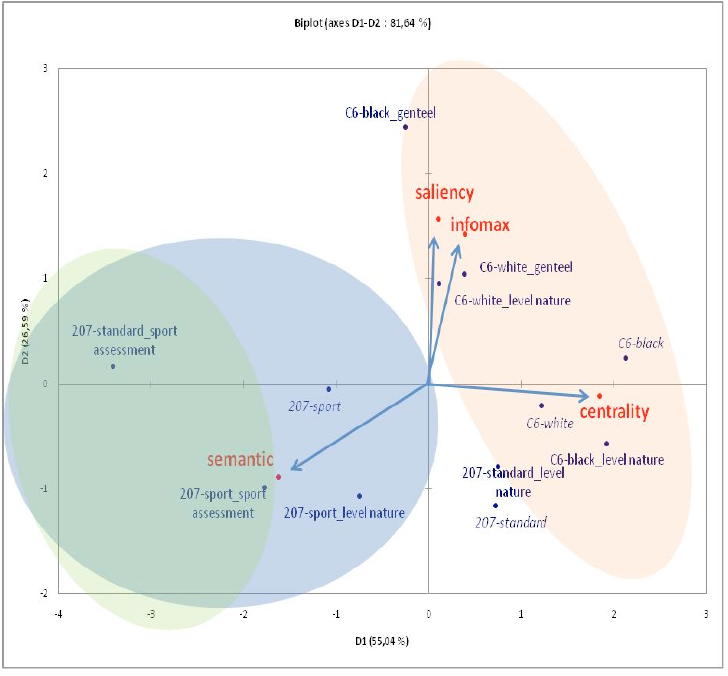
Figure 8: Projection of each experimental condition on the first two principal components (81.64% of the observed